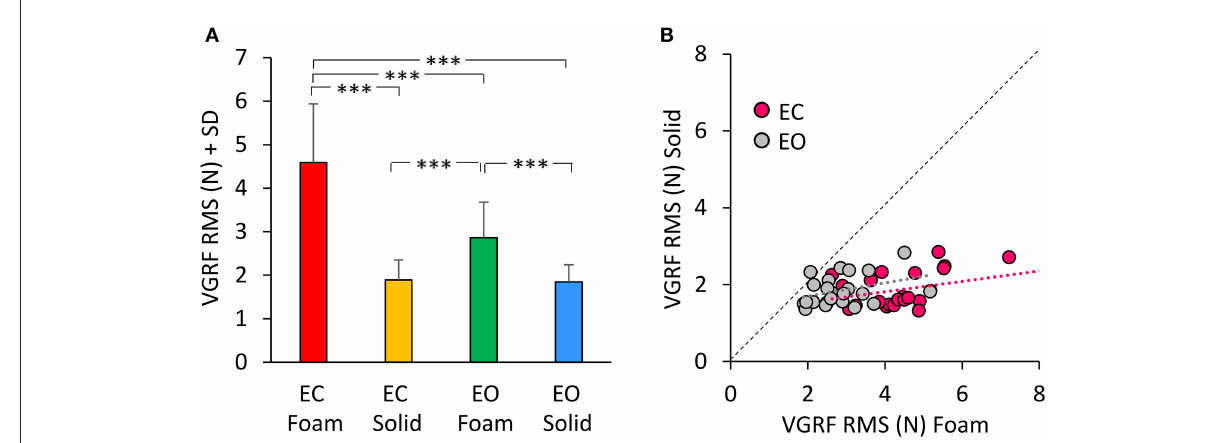
FIGURE2 The VGRF Root Mean Square (RMS). (A) The mean values of VGRF RMS are shown for the two vision conditions (eyes closed, EC; eyes open, EO) and for the two bases of support (Foam and Solid). (B) The values of VGRF RMS for Solid are plotted against those for Foam, for each subject and vision condition (EC, pink dots; EO, gray dots). The black dotted line is the identity line. The VGRF RMS were greater with Foam than Solid under both vision conditions. The equations of the regression lines fitting the Solid vs. Foam data were: EC, y = 0.14 x + 1.27 (R 2 = 0.16, p = 0.06); EO, y = 0.17 x + 1.35 (R 2 = 0.13, p = 0.09). Asterisks indicate significant differences (*** p <